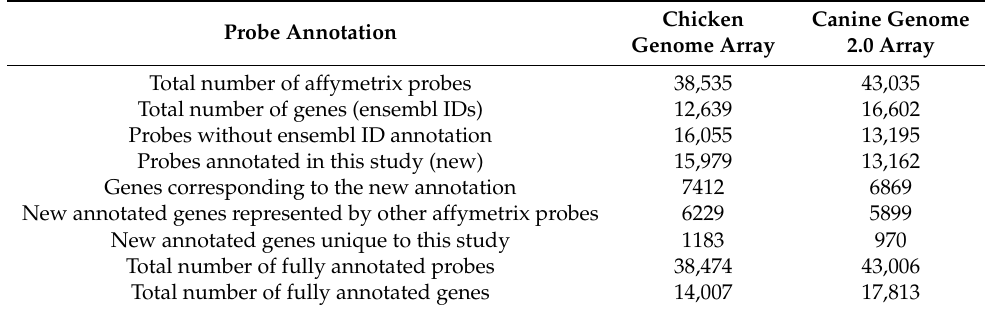
Table 1. Annotation of affymetrix probe sets with no ensembl identifications (IDs).